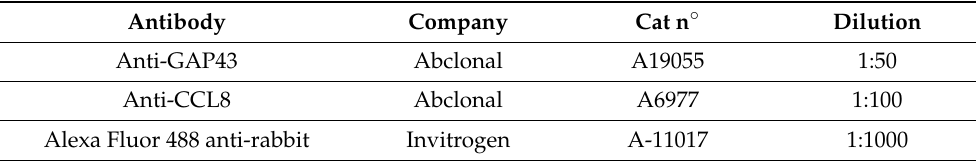
Table 2. List of antibodies used for immunofluorescence. Antibody Company Cat n ◦ Dilution Anti-GAP43